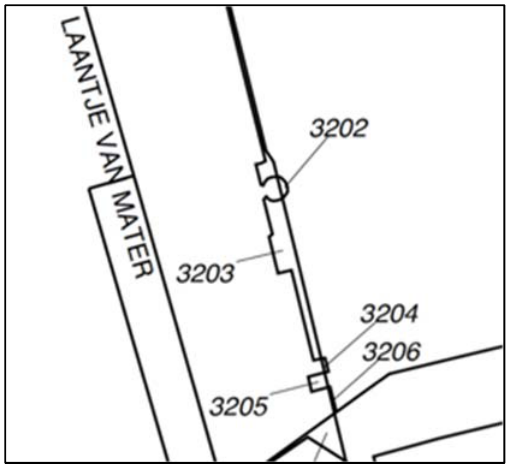
Figure 12. Tiny parcels due to the division of ground parcels in the Delft case to permit the 2D map to reflect objects above and below the surface.